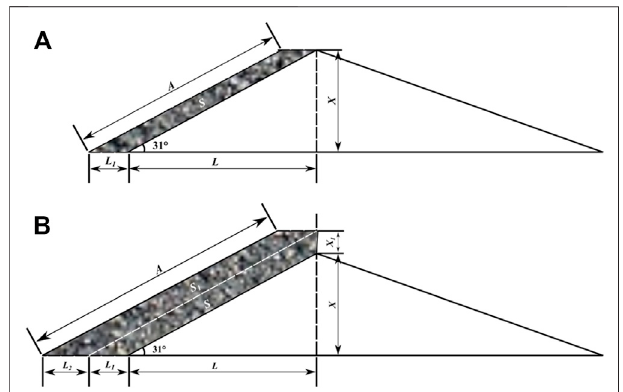
FIGURE 11 | Schematic diagram of sand dune migration velocity prediction model under the shelterbelt system, reproduced with data kindly provided by Dr. Wang Haifeng, Chinese Academy of